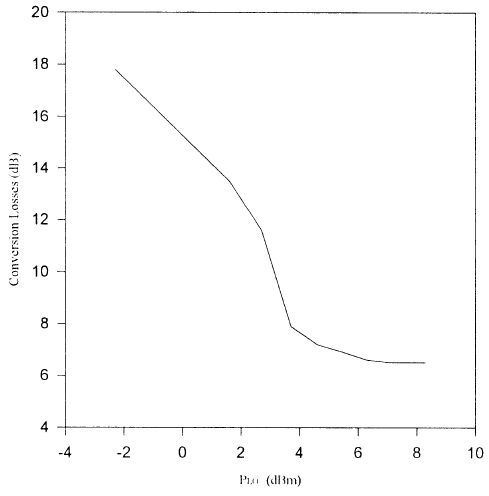
FIGURE 34 Conversion loss vs. the P LO .